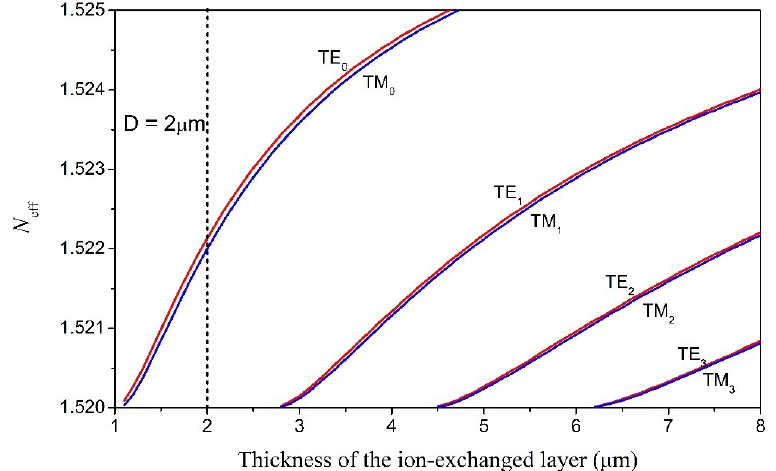
Figure 1. Effective refractive indices of the TE modes in the ion-exchanged glass waveguide as a function of the thickness of the ion-exchanged layer.